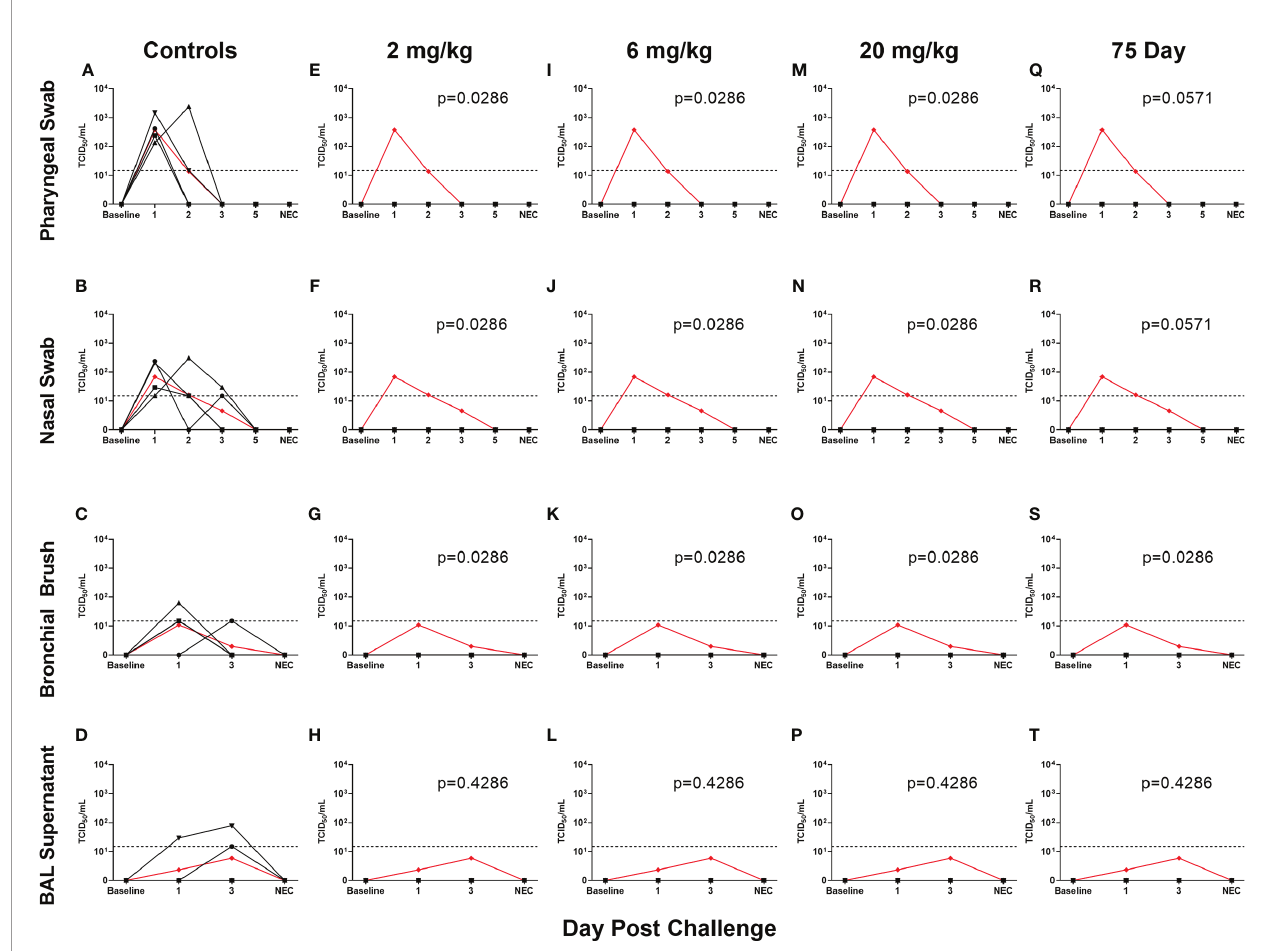
FIGURE 3 | Viral Loads Assessed via Median Tissue Culture Infectious Dose (TCID50) During Challenge. Viral loads from pharyngeal swabs (A, E, I, M, Q) , nasal swabs (B, F, J, N, R) , bronchial brushes (C, G, K, O, S) and BAL supernatant (D, H, L, P, T) assessed TCID50 for controls (A – D) , 2 mg/kg (E – H) , 6 mg/kg (I – L) , 20 mg/kg (M – P) and 75 day challenge (Q – T) groups. Data are represented as viral load calculated by the Reed and Muench method, with the red line indicating control group mean and the dotted line indicating the quanti fi cation limit of